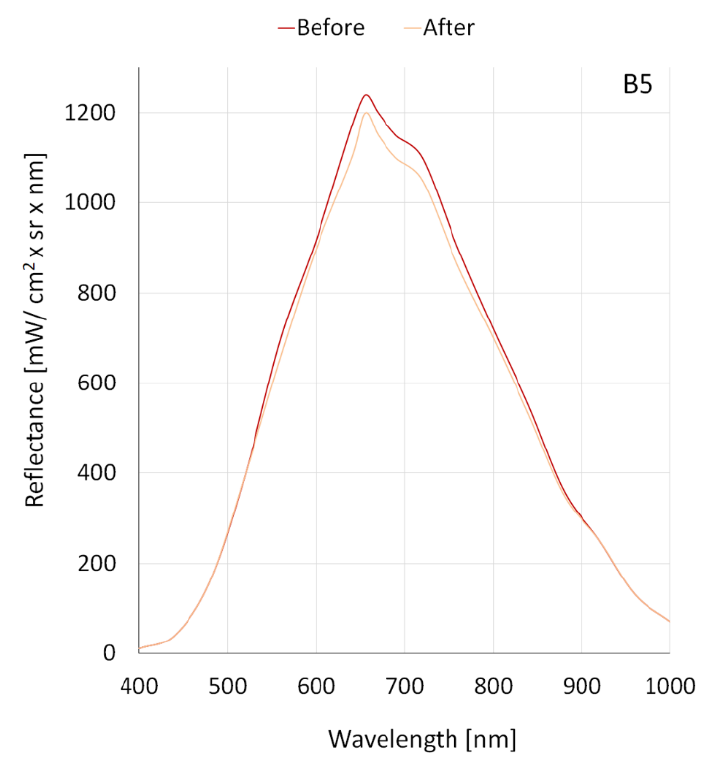
Figure 10. The correlation between the reflectance and the wavelength for the B5 dye before and after the use of the Q-Switched Nd:YAG laser.